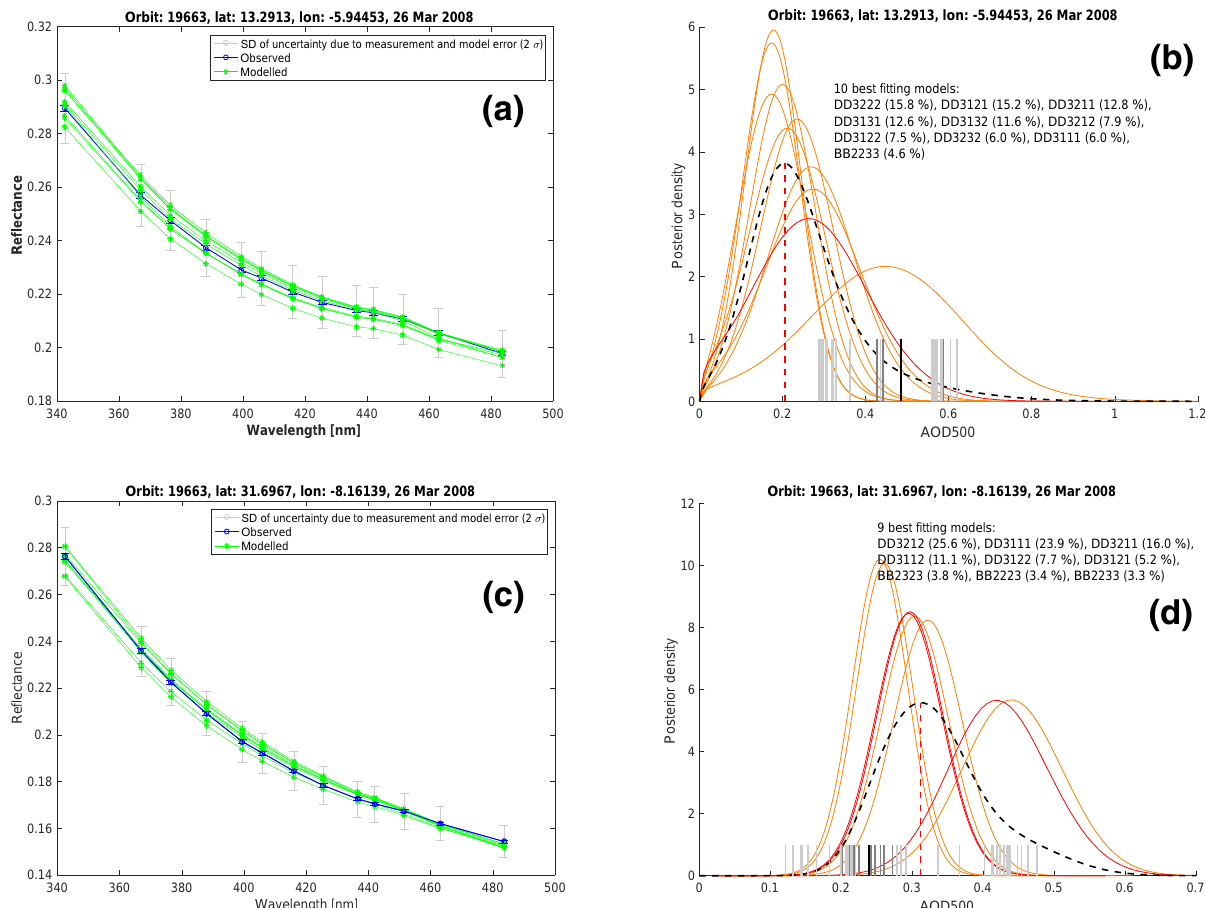
Figure 15. Same as Fig. 14 but for the pixels located at IER_Cinzana (a, b) and Saada (c, d) . (b, d) The desert-dust-type models’ posterior density curves are marked with orange and biomass-burning-type models with